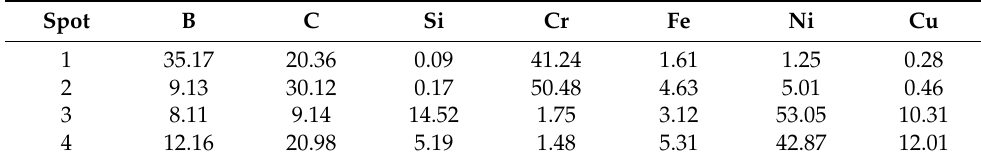
due to the higher copper content at the bottom of the